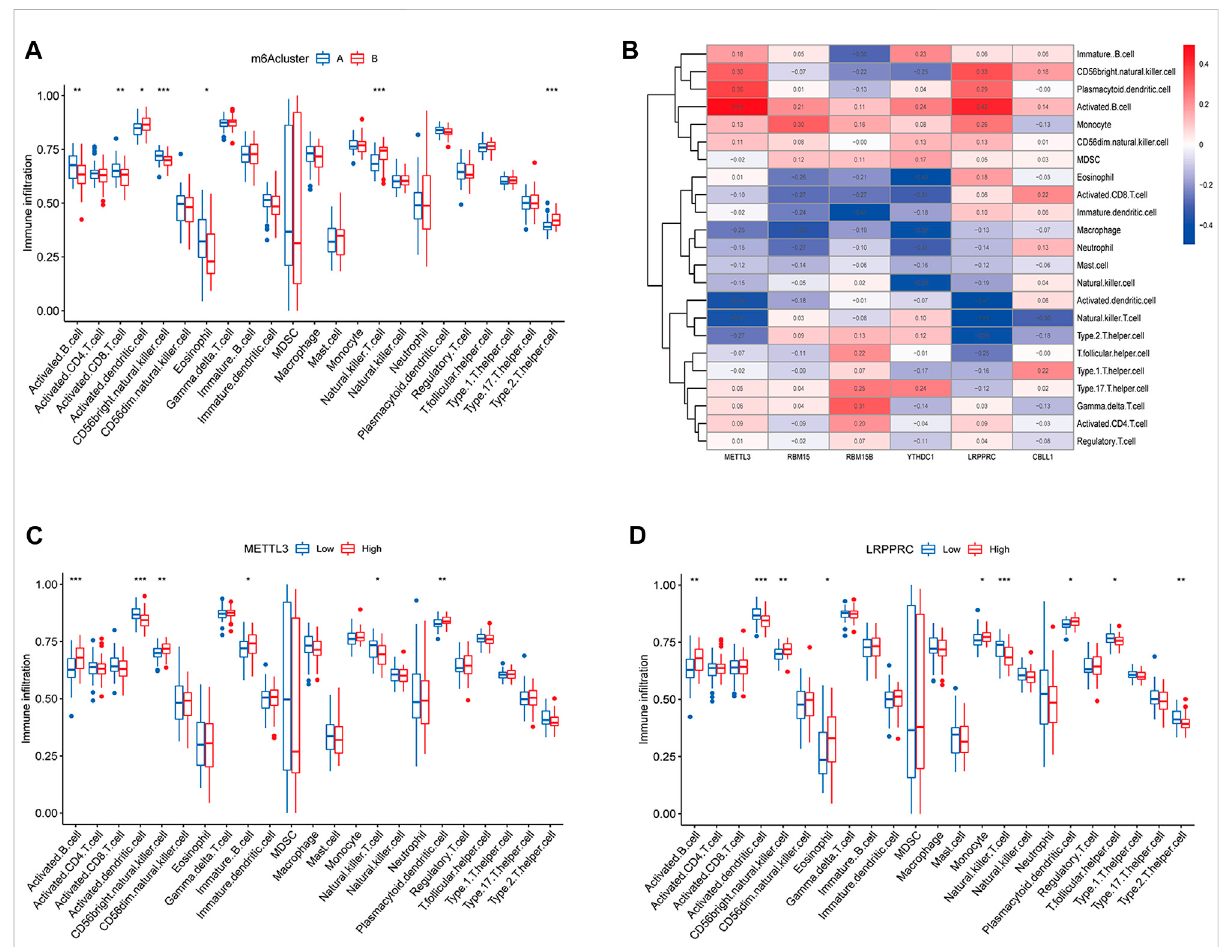
FIGURE 4 Immune cells in fi ltration analysis of m6A regulators. (A) Box diagram of immunocyte abundance in molecular subgroups of m6A regulators. (B) Heatmap of correlation between immunocyte abundance and m6A regulators expression. (C) Box diagram of comparison of immunocyte abundance in the METTL3 high- and low-expression groups. (D) Box diagram of comparison of immunocyte abundance in the LRPPRC high- and low-expression